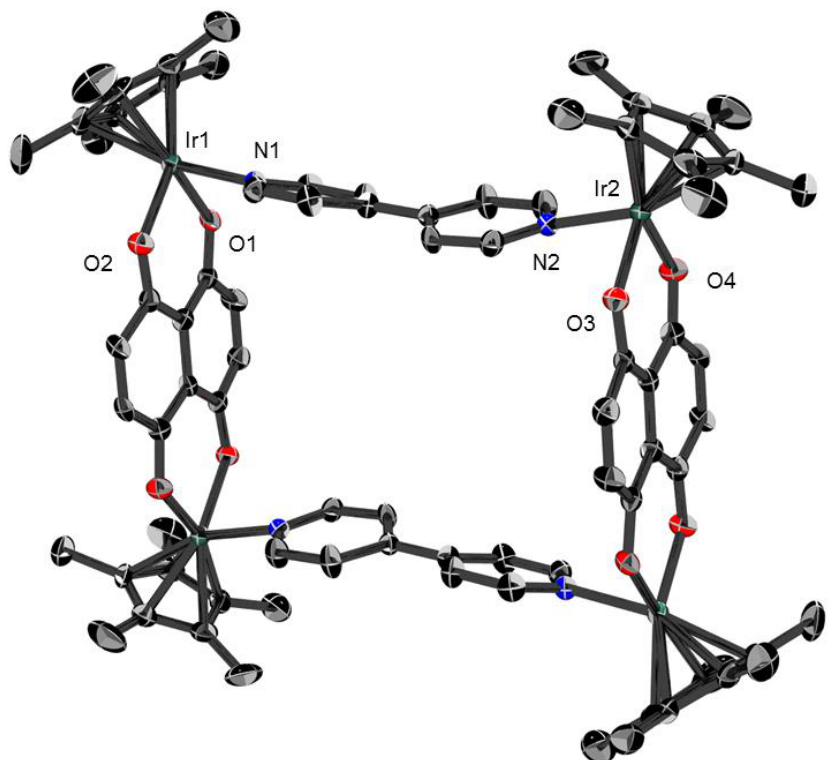
Figure 5. Molecular structure of metalla-rectangle 6 at 50% probability level ellipsoids with hydrogen atoms, solvent molecules and triflate anions omitted for